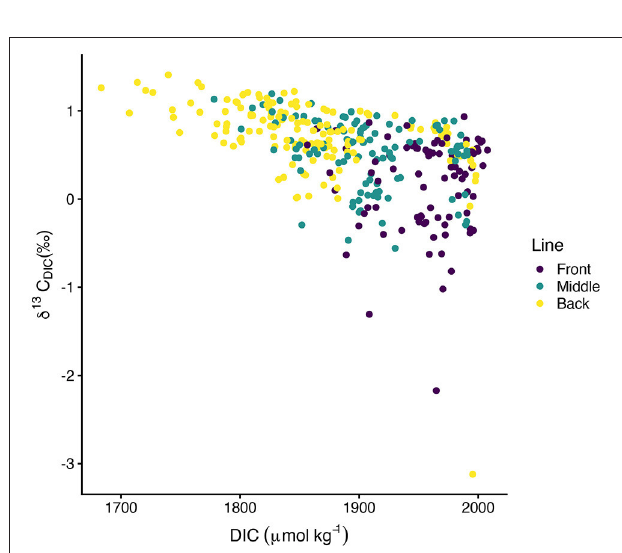
FIGURE 6 | Scatter plot of δ 13 C DIC vs.